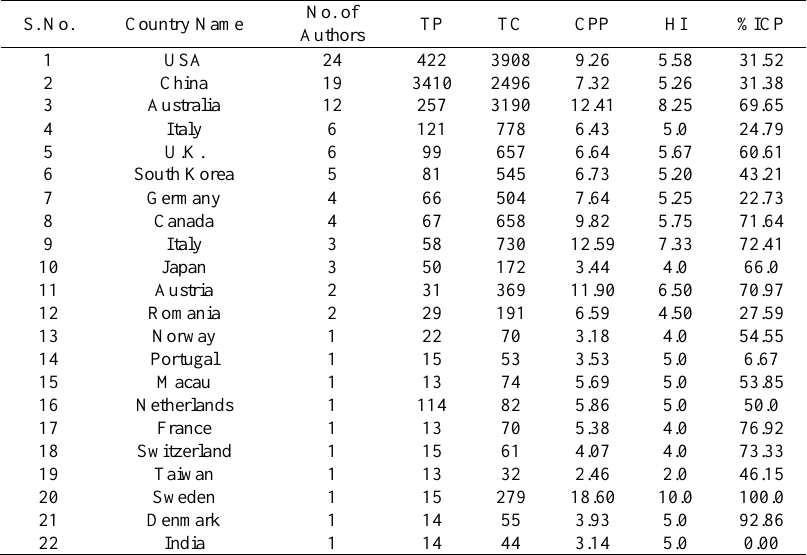
Table 8. Publication and Citation Profile of Top 100 Authors by Country of Origin: 2007-16. S.